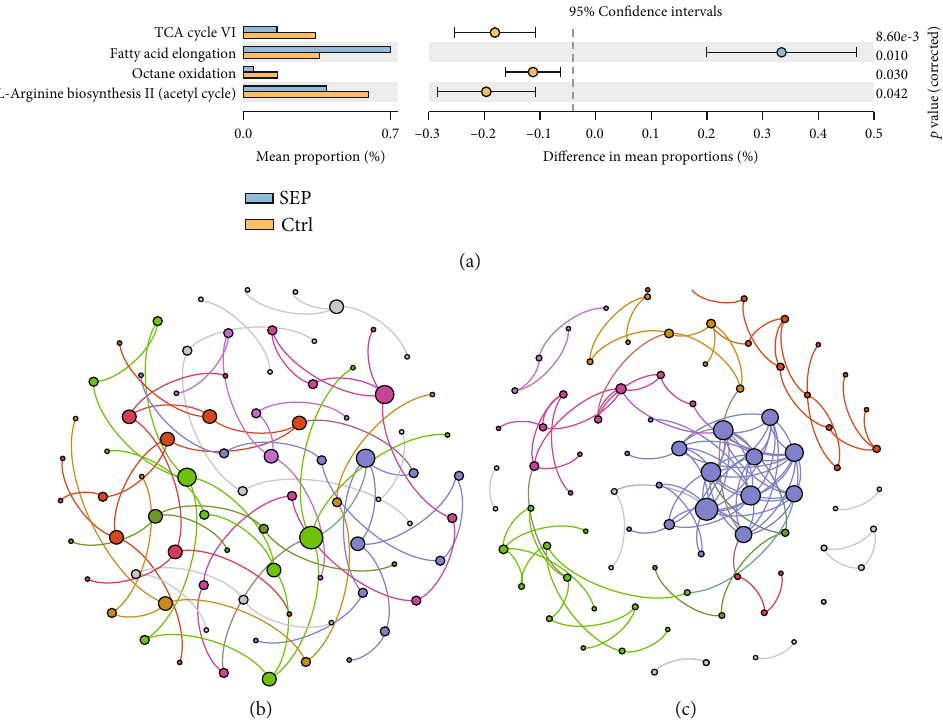
Figure 4: Functional metabolic pathways and microbial ecological network in the SEP and Ctrl groups. (a). Signi fi cantly di ff erent metabolic pathways between SEP and Ctrl groups. (b). Microbial ecological network of the gut microbiome in the patients with sepsis. (c). Microbial ecological network of the gut microbiome in the healthy